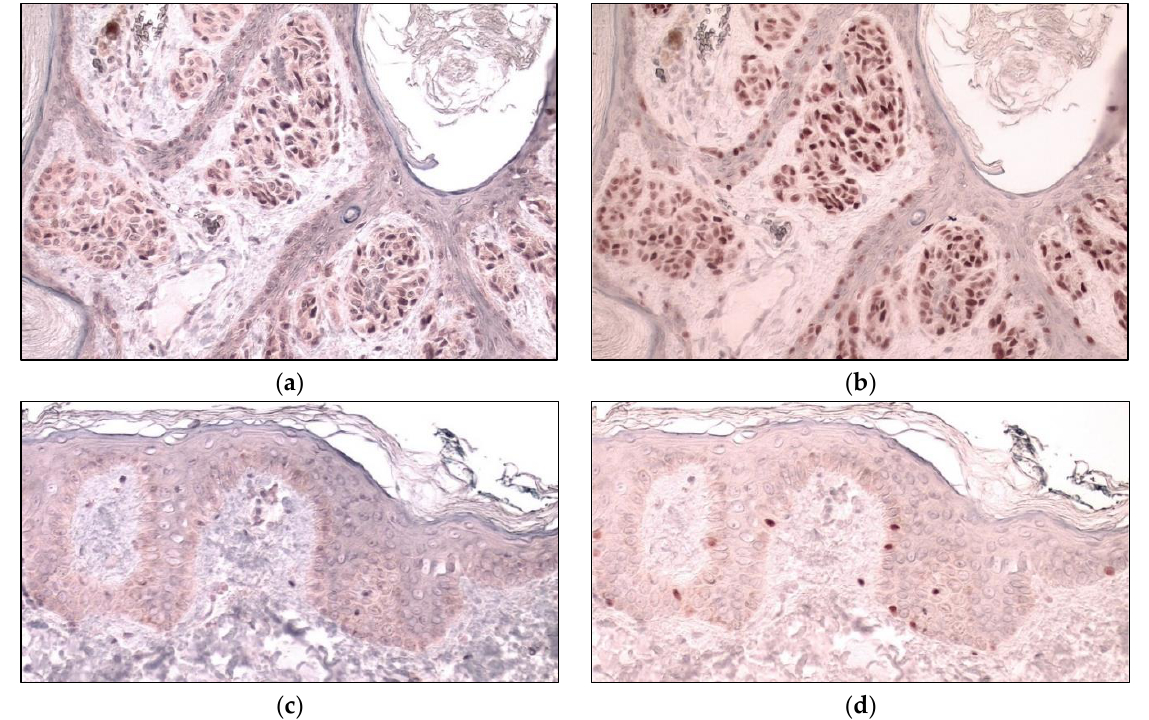
Figure 4. Expression of gankyrin in normal melanocytes versus neoplastic melanocytes. Sequential dual immunohistochemical staining was performed on the same slide for gankyrin ( a , c ) and SOX-10 ( b , d ) in a nevus ( a , b ) and in the adjacent uninvolved skin ( c , d ). Melanocytes identified by SOX-10 expression on average stain more strongly for gankyrin in the nevus than in normal skin. ( a , b ) 200×; ( c , d ) 400×.